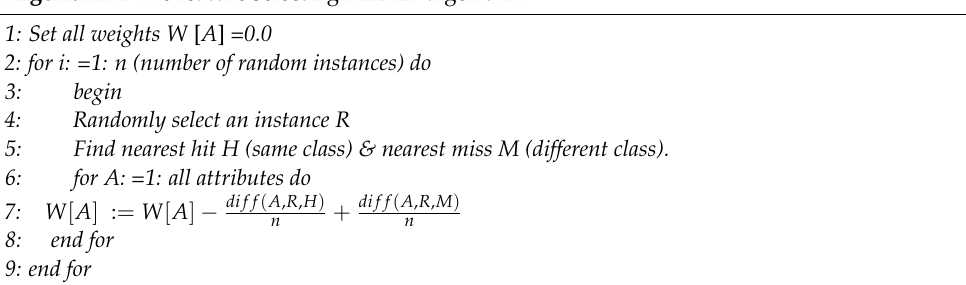
Algorithm 1 The feature selecting RELIEF